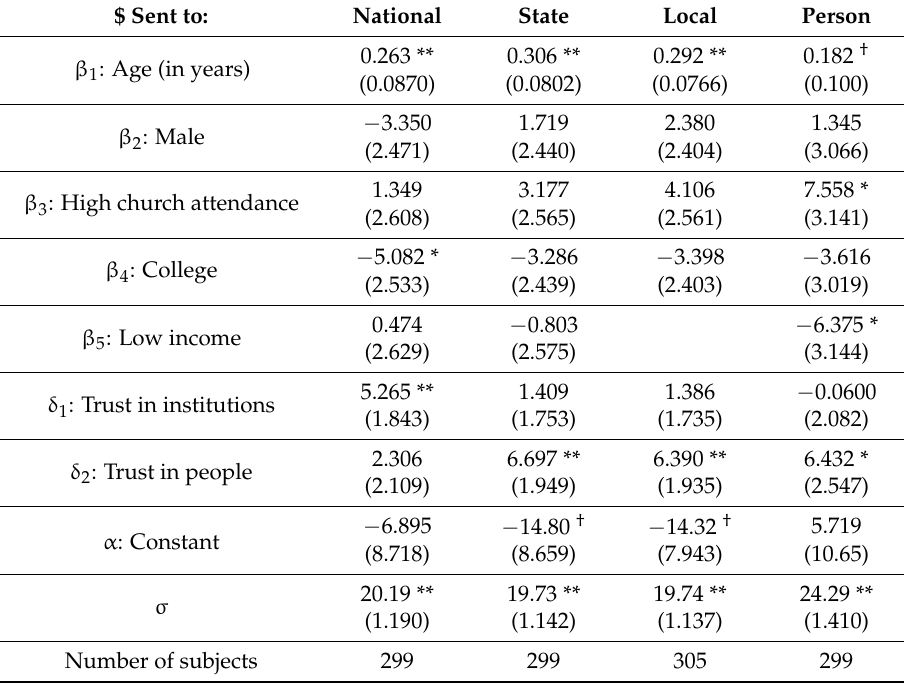
Table 5. Tobit results for comparative dictator game by charity level